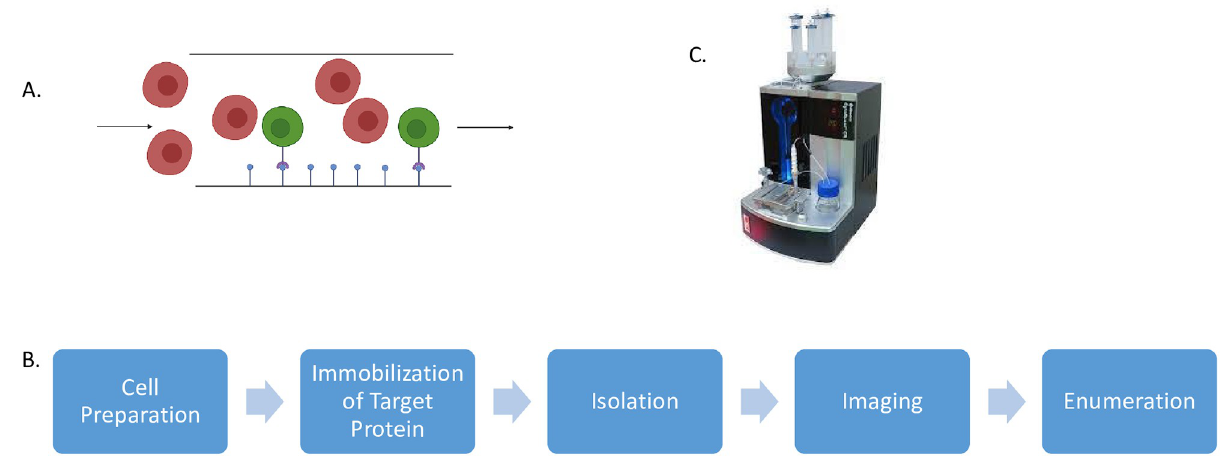
Fig 1. Cytoquest schematic and workflow. (A) Cellular level diagram of ligand coated slide chamber coated microfluidic slide chamber. Green cells express the appropriate receptor to the ligand and are captured onto the chamber. (B) Workflow diagram. (C) Abnova Cytoquest.